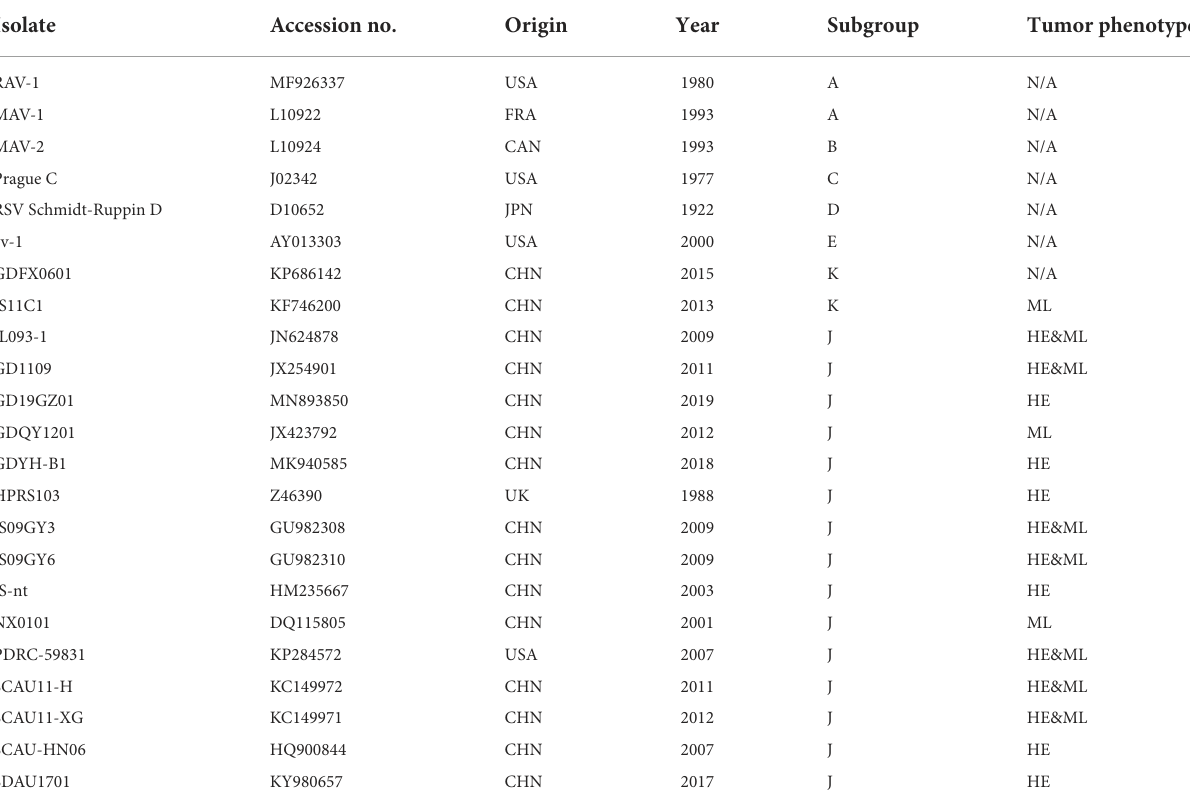
TABLE 3 ALV strains used for comparison of the sequence. Isolate